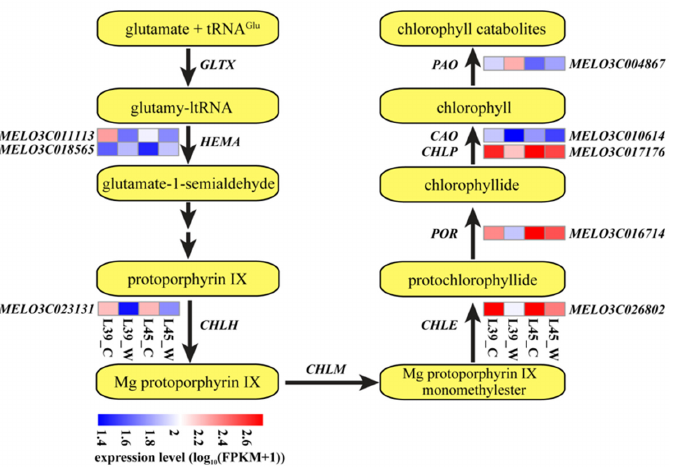
Figure 7. Expression of genes relevant to chlorophyll metabolism in ‘L39’ and ‘L45’ under control and waterlogging stress conditions. The levels of gene expression are shown by log 10 (FPKM+1). GLTX, glutamyl-tRNA synthetase; HEMA, glutamyl-tRNA reductase; CHLH, magnesium-chelatase subunit H; CHLM, magnesium-protoporphyrin O-methyltransferase; CHLE, magnesium-protoporphyrin IX monomethylester oxidative cyclase; POR, protochlorophyllide oxidoreductase; CHLP, geranylgeranyl reductase ; CAO, chlorophyllide a oxygenase; PAO, pheophorbide a